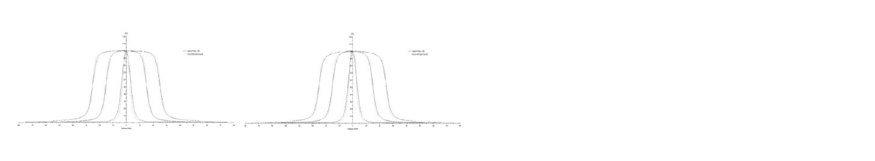
Fig 9. In-plane profiles at a 100-cm depth for the 0.6 × 0.6 cm 2 , 3 × 3 cm 2 , and 5 × 5 cm 2 fields for the 6 MV (left) and 6 MV FFF (right) beams with different detectors.